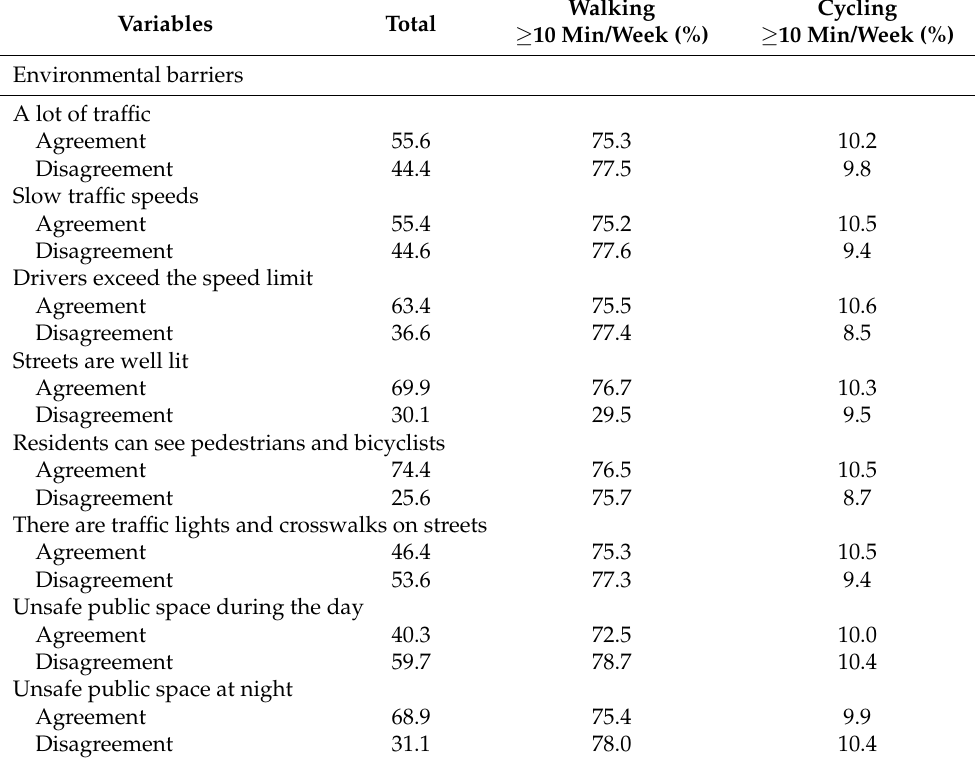
Table 3. Perceived neighborhood safety indicator and active transportation in